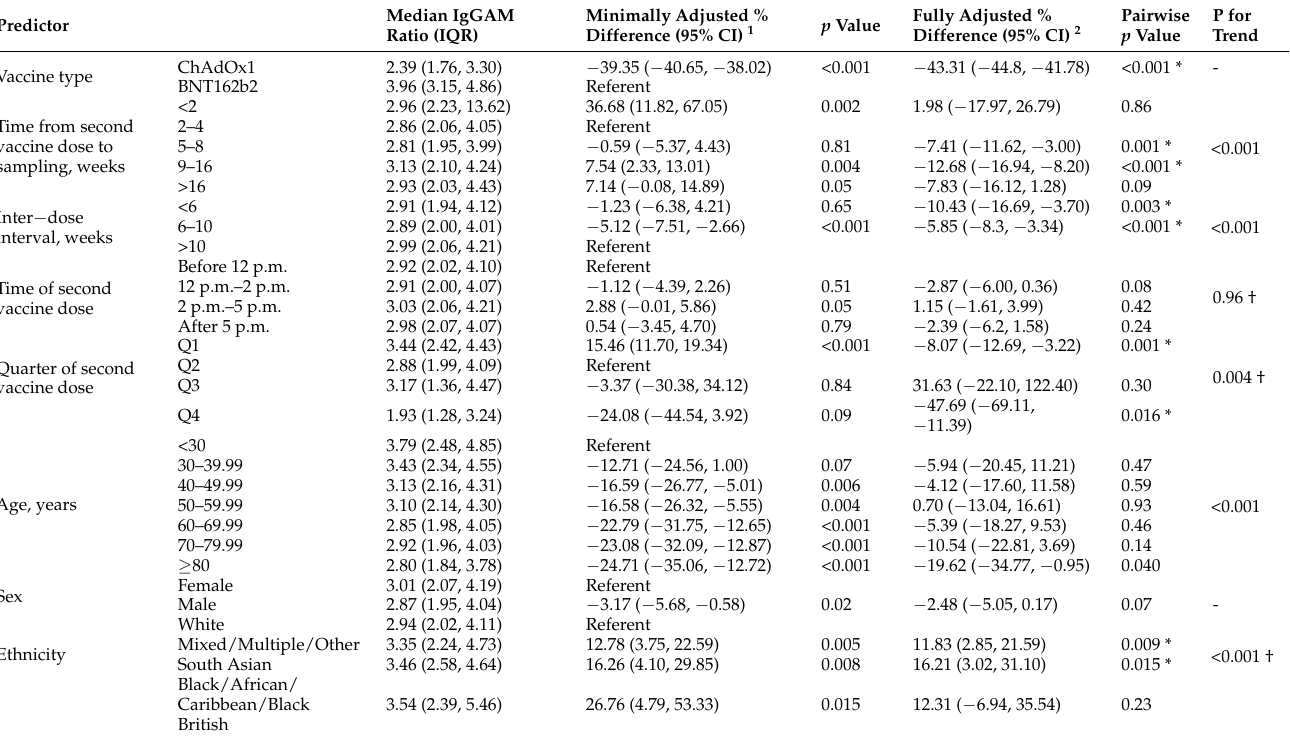
Table 3. Determinants of post-vaccination antibody titres, subset of seropositive participants ( n =